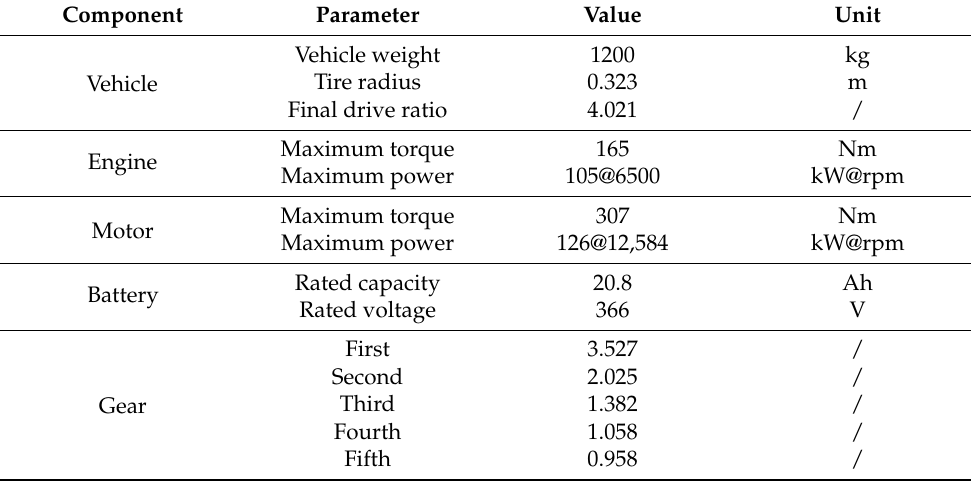
Table 2. Vehicle and component parameters in the studied vehicle. Component Parameter